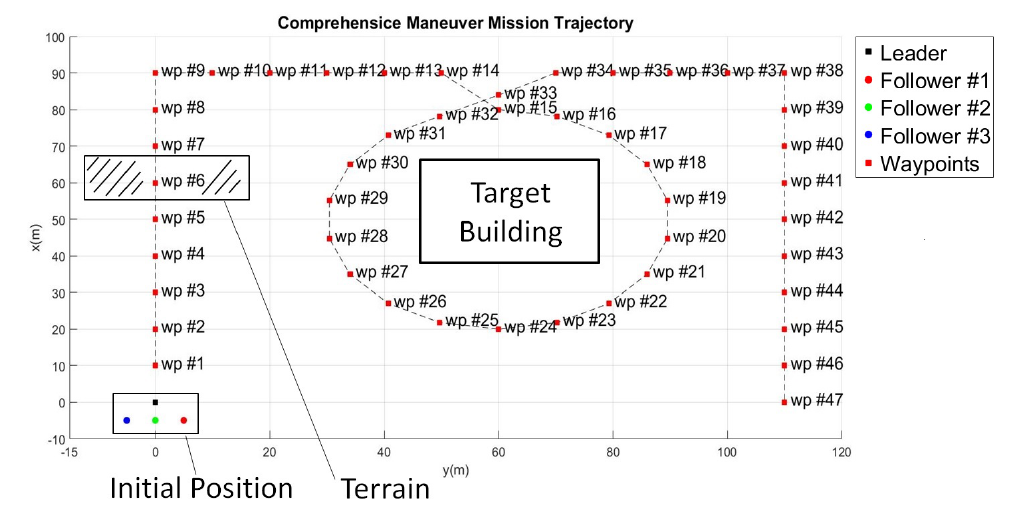
Figure 12. Comprehensive maneuver mission trajectory.